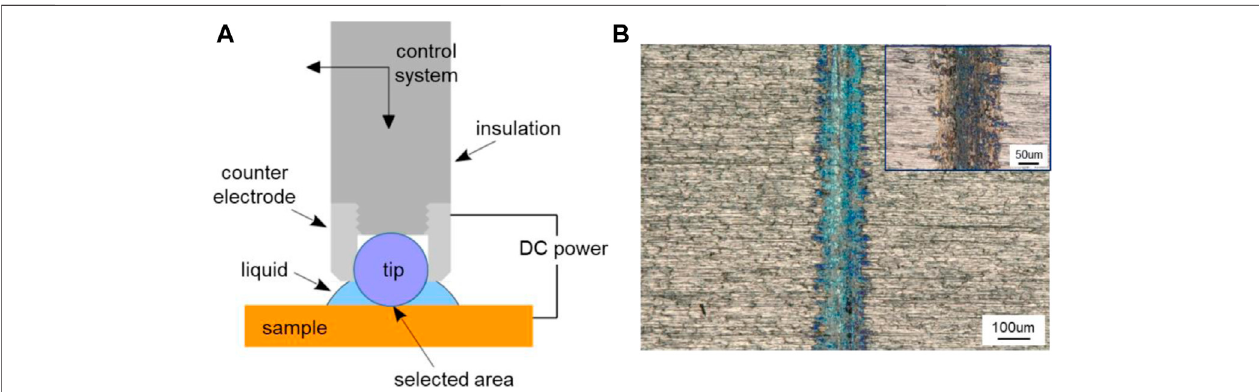
FIGURE 13 | Localized oxidation coloring of metal surface based on triboelectrochemical reactions. (A) Schematic illustration of the device for localized oxidation coloring and (B) microscopic image of Ti surface coloring obtained with a positive potential of 1.5 V, and the image of the track obtained without applied potential as shown in the